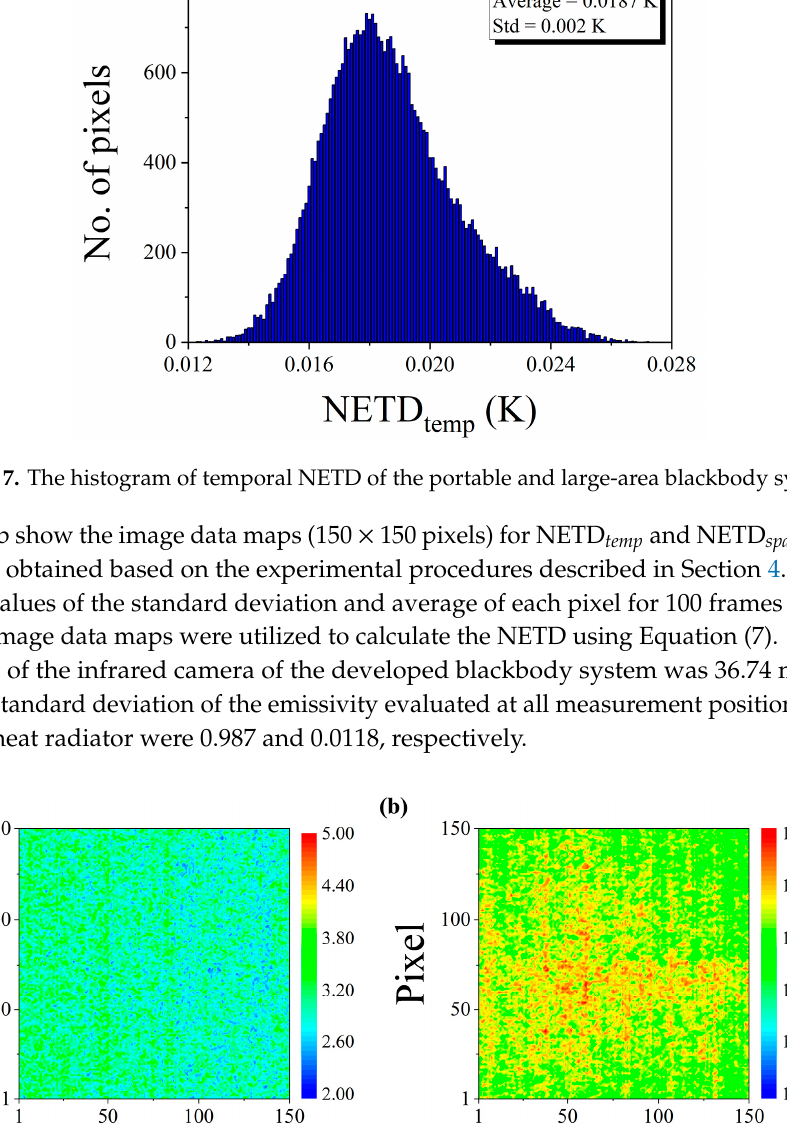
Figure 6. Signal transfer function (SiTF) curve of the portable and large-area blackbody system.